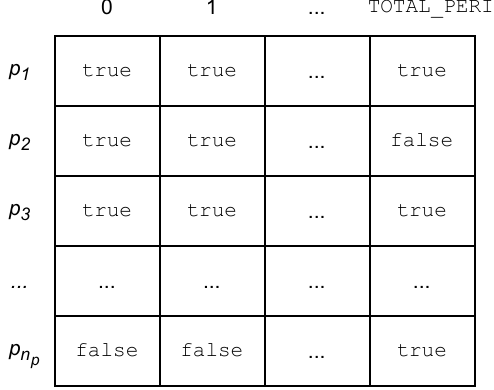
Figure 4. Professors’ shift preferences